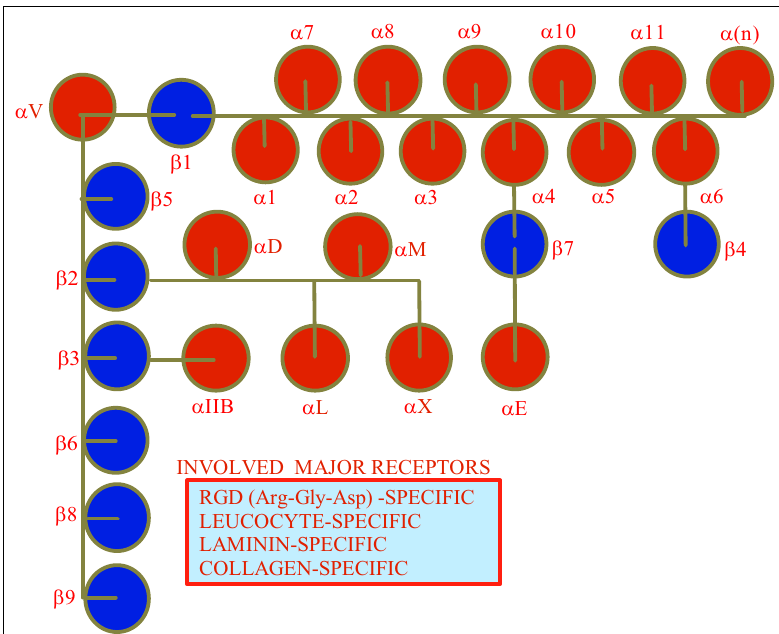
Figure 1: Integrin superfamily of vertebrates ’ origins including humans. With the α and β subunits combining to form heterodimeric integrins, and the ongoing discoveries, the number of α and β subunits are increasing {( α ) n and ( β ) n } to add to new integrin